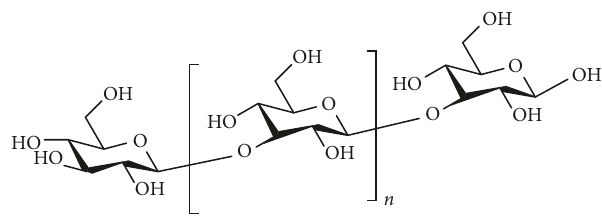
Figure 1: Chemical structure of